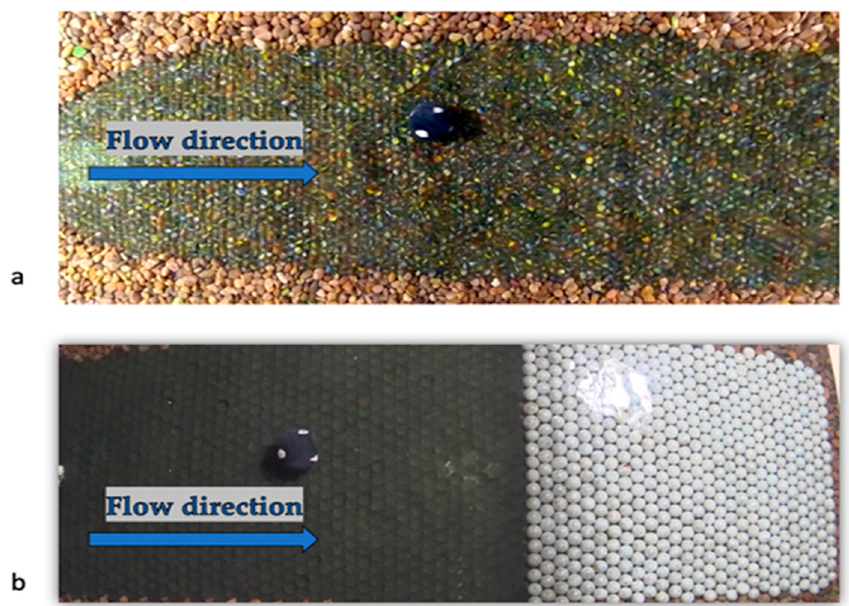
Figure 4. Photographs extracted from the videos obtained from the cameras placed atop the flume, illustrating the field of view captured during the experimental runs and covering the full extent of the experimental test section, for bed surface: ( a ) A and ( b ) B.